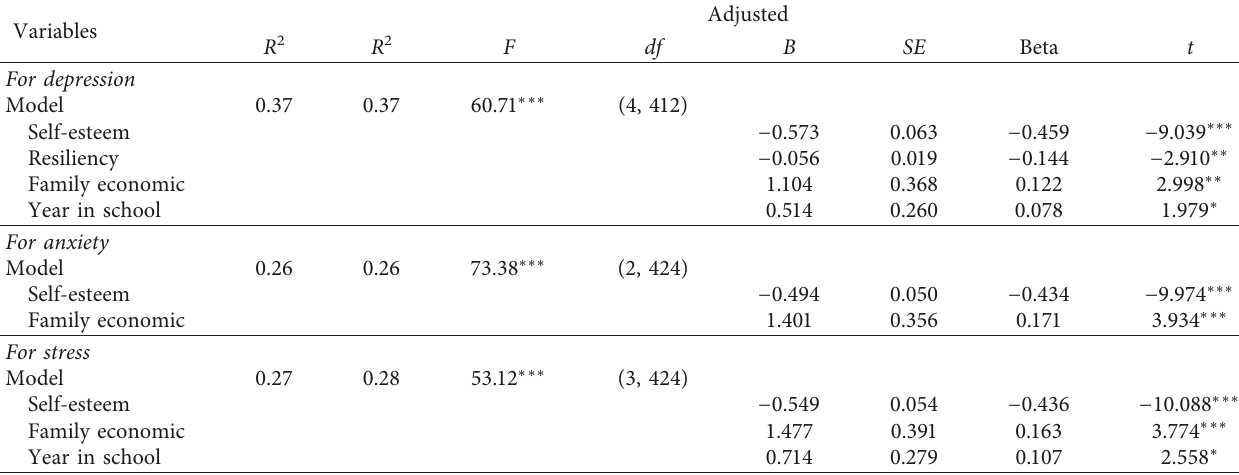
Table 2: Multiple regression analyses of variables predicting mental health